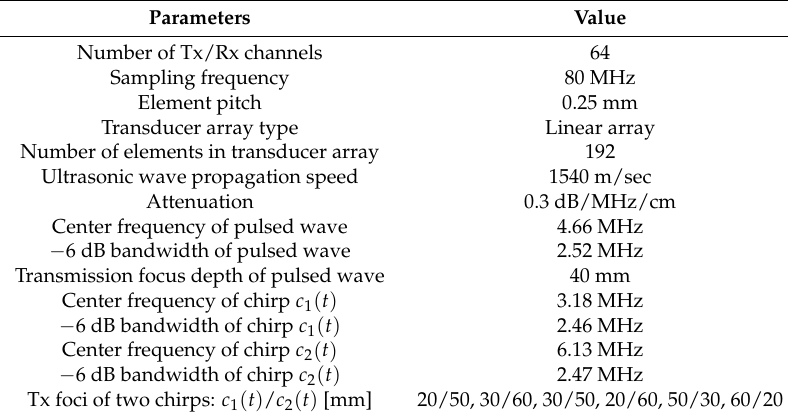
Table 1. Simulation